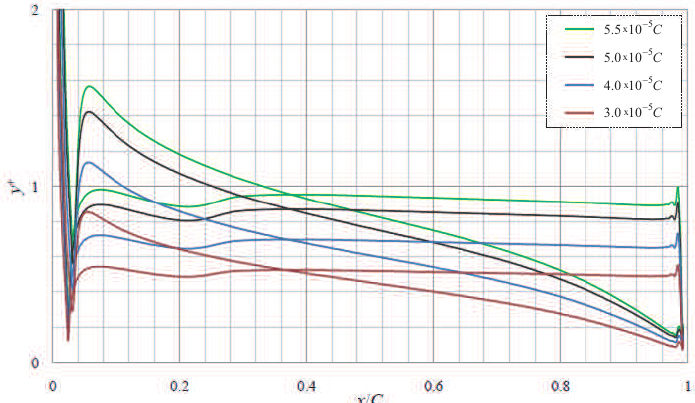
Figure 5. Non-dimensional near-wall values along the airfoil for various first layer thicknesses ( α = 10 ◦ , Re = 3.6 × 10 5